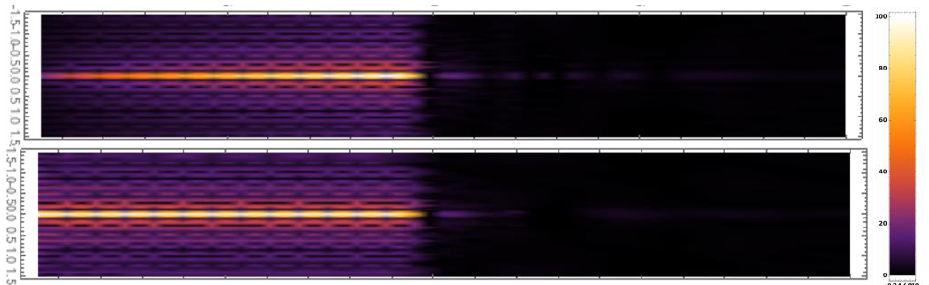
Figure 6. 5 MHz ultrasound beampatterns from the sum of the first 200 orders of spherical Bessel Functions with (top) √𝑛 weighting and (bottom) equal weighting on a flat, radially symmetric transducer located at the left-hand side of each figure. Linear amplitude plots are shown with lateral range − 1.5 to 1.5 mm and axial range from the origin to 20 mm. On the far right is the color bar used for beampattern figures, with the vertical scale indicating the percent of the maximum value.